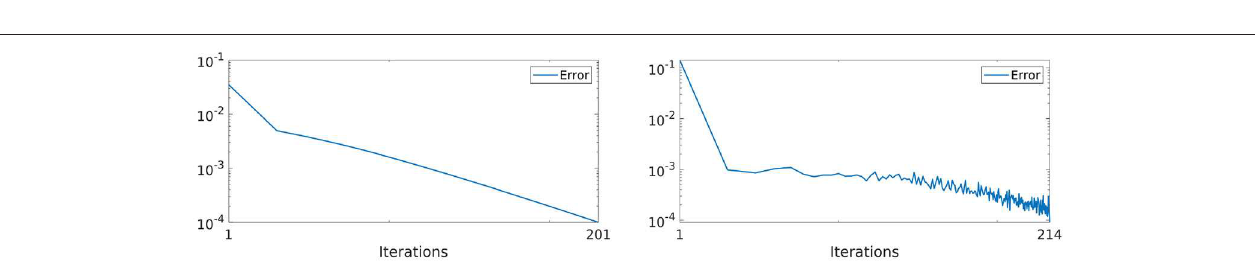
FIGURE 2 | Convergence of the error e k [see Equation (21)] in logarithmic scale with the GD (left) and GD-RBM (right)